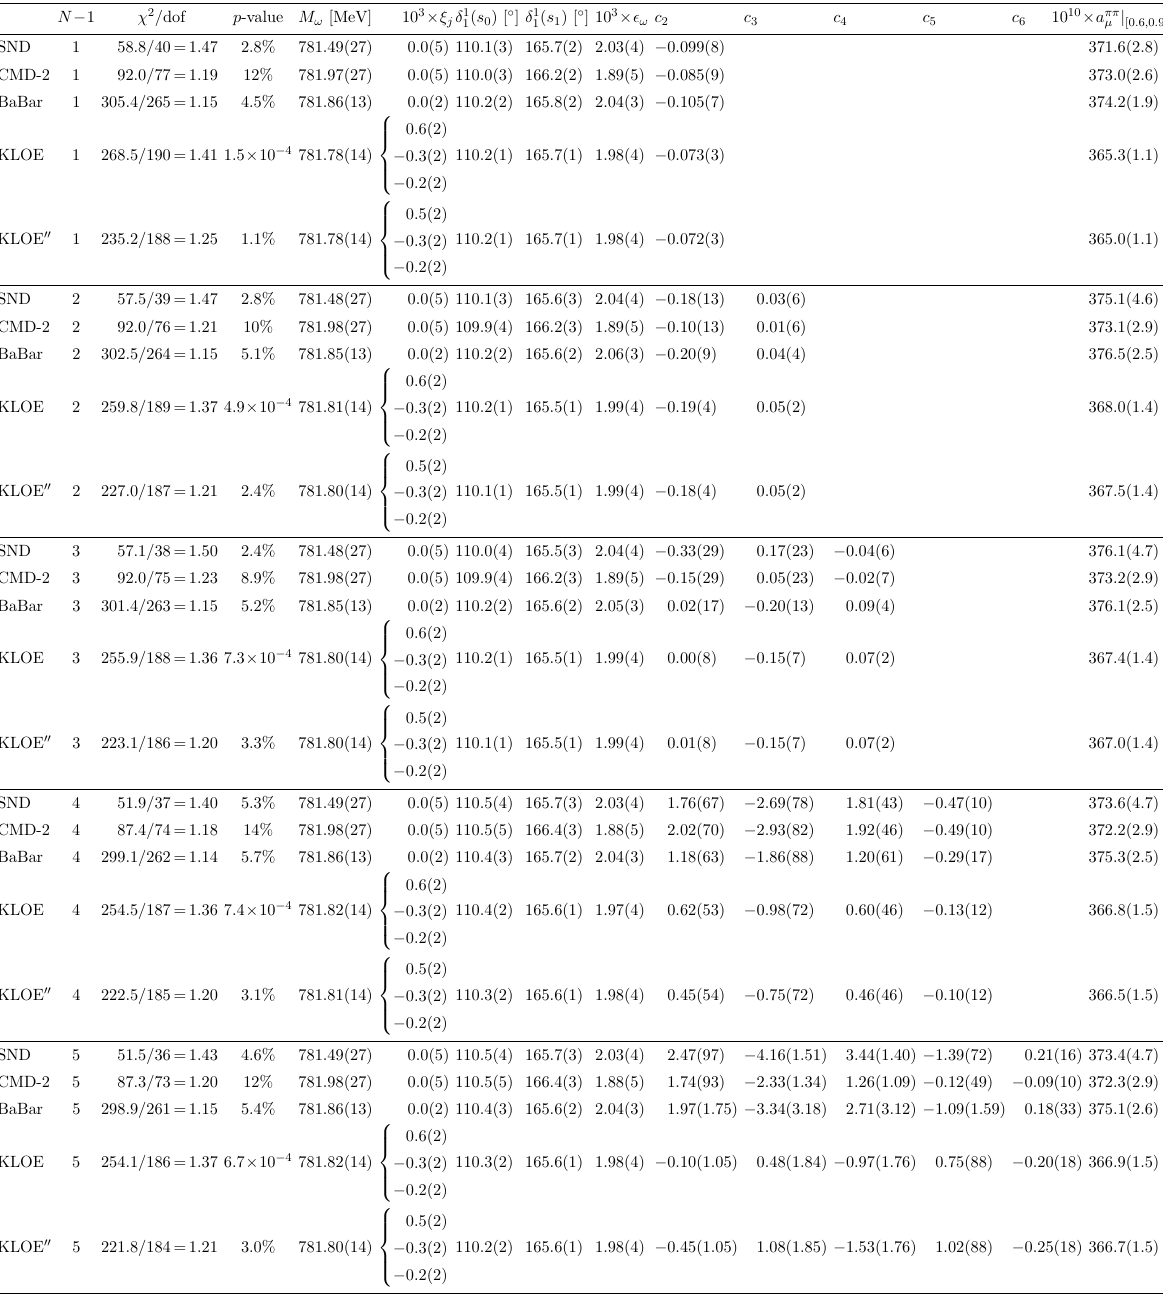
Table 8. Fits with various values for the order N of the conformal polynomial that describes the